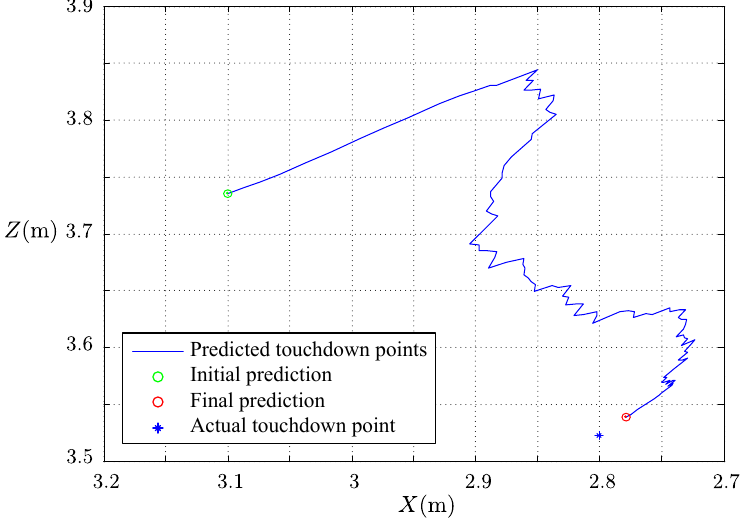
Figure 12. Prediction of the touchdown